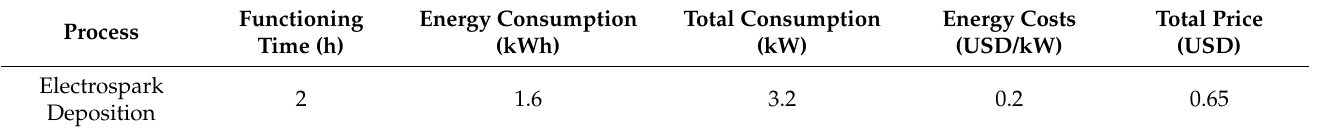
Table 5. Electrospark deposition costs for 100 × 100 × 0.05 mm surface deposition.